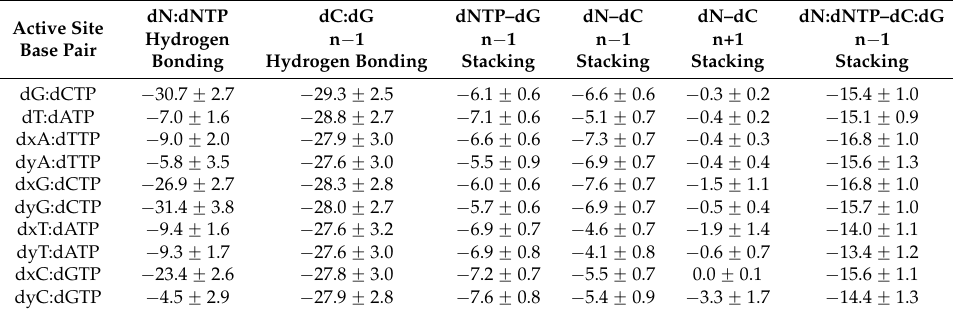
Table 5. AMBER linear interaction energies (kcal ¨ mol ´ 1 ) for the dN:dNTP base pair during 40 ns MD simulations of the Dpo4 ternary complex for the replication of a DNA, xDNA or yDNA base a . Active Site Base Pair